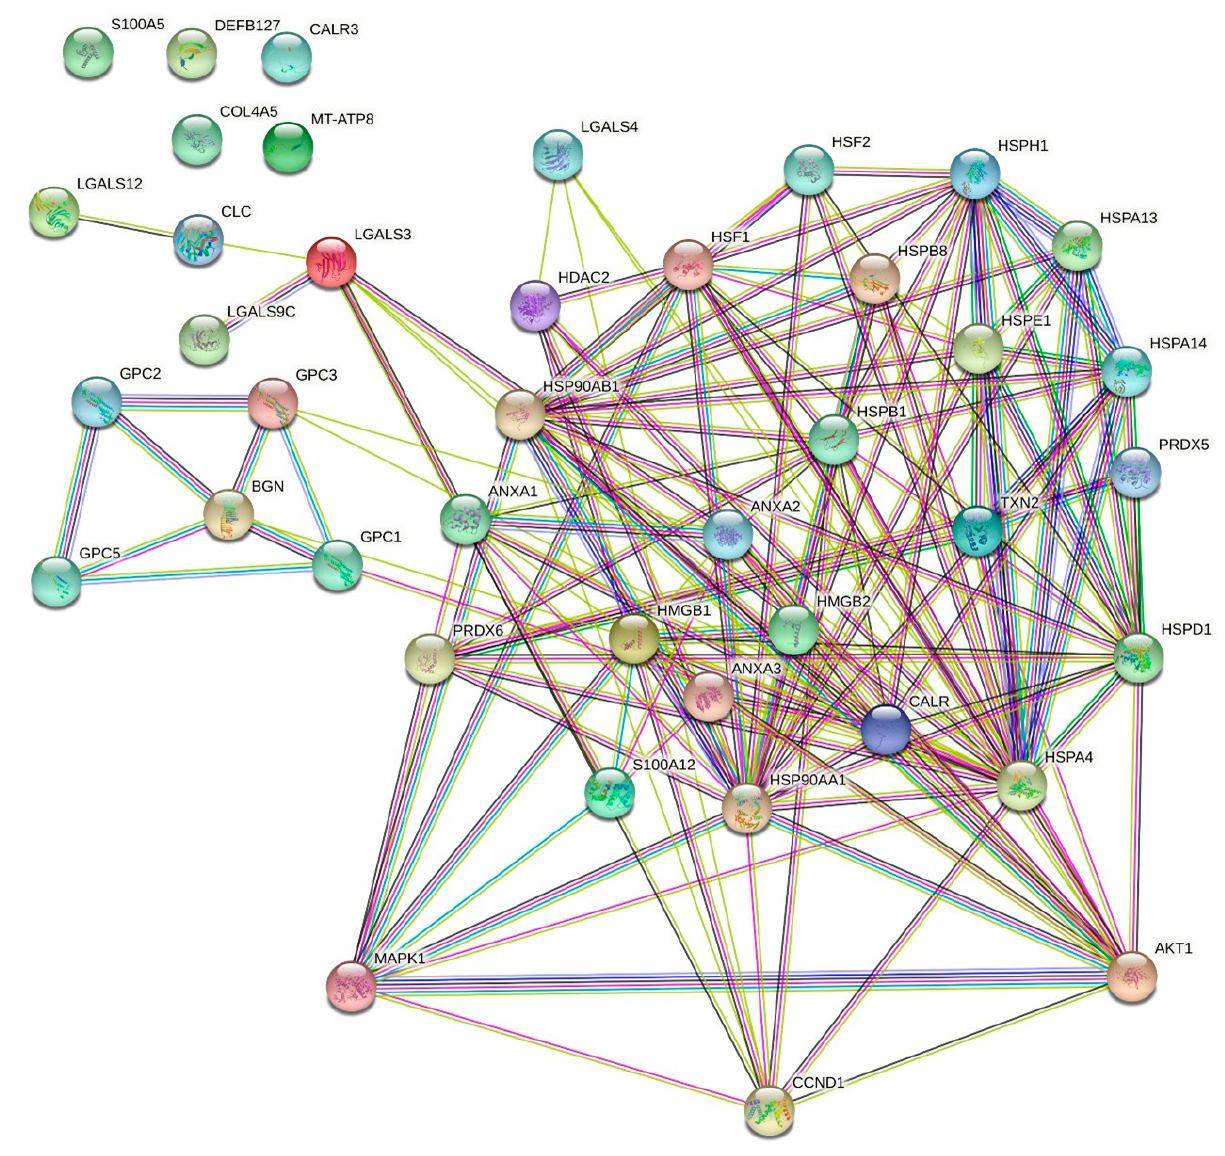
Figure 6. Postulate interaction of DAMPs and representative signaling proteins. Protein–protein interaction analysis was used to represent the association of DAMPs and crucial protumor signaling by using STRING software (http://string-db.org, accessed on 15 July 2022).